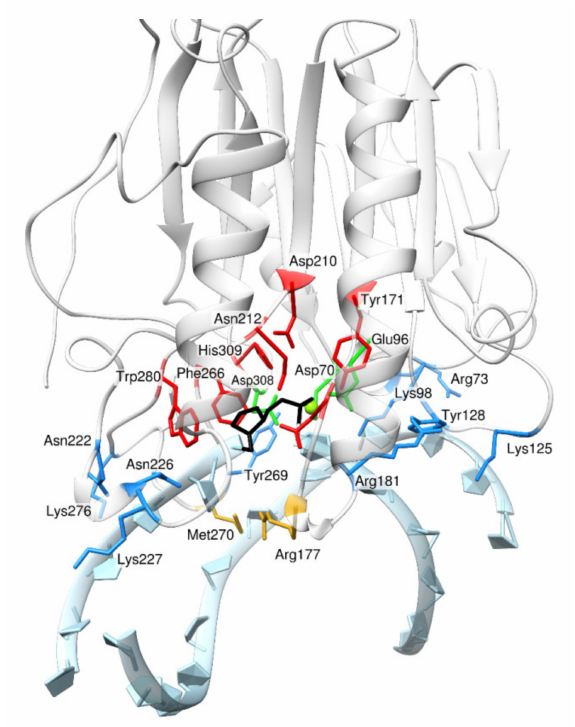
Figure 1. The model of hAPE1 complexed with DNA containing an F-site [29]. Active-site amino acid residues Tyr171, Asn174, Asp210, Asn212, Phe266, Trp280, and His309 are red; Mg 2+ -coordinating residues Asp70, Glu96, and Asp308 are green; DNA-binding–site residues Arg73, Lys98, Lys125, Tyr128, Arg181, Asn222, Asn226, Lys227, Lys276, and Tyr269 are blue; and intercalating residues Met270 and Arg177 are yellow. The F-site is